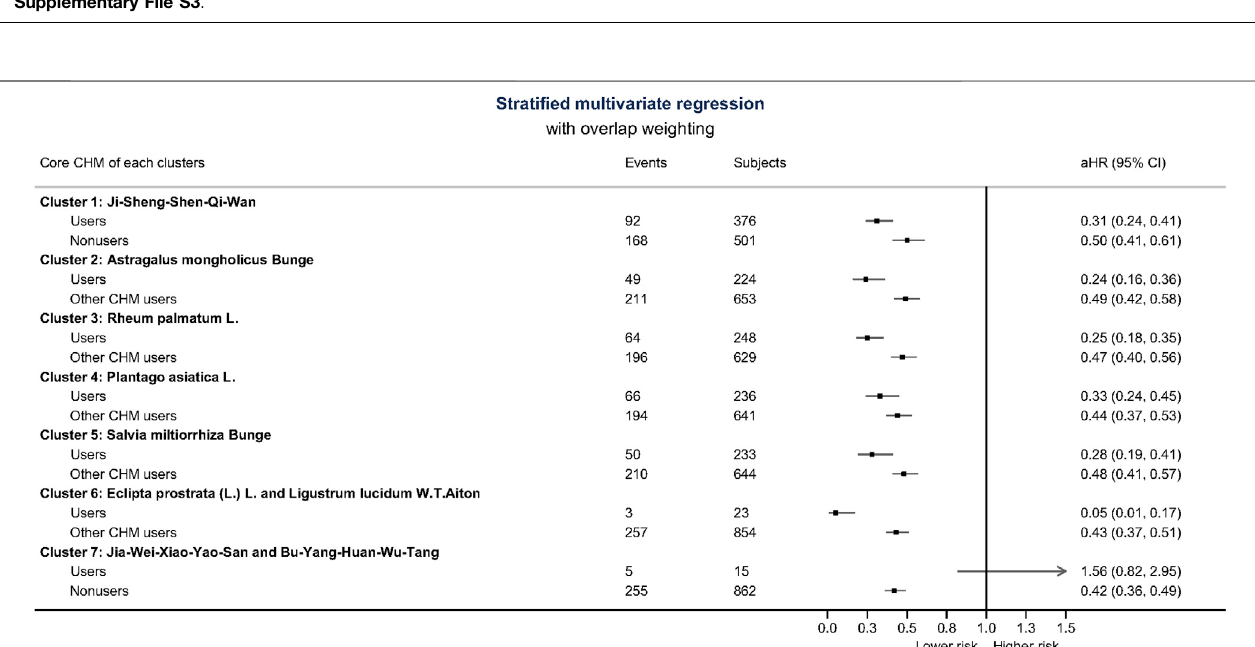
FIGURE6| Theassociations ofusingcoreChineseherbalmedicine(CHM)orotherCHMswithall-causemortalityreferencetoCHMnonusers.Generally,subjects using coreCHMwitheveryclusterhad lowerrisks.Cluster6and7arepresented astwoCHMsincombinationrather thancoreCHMsince therewereonlytwoCHMs in clusters 6 and 7. The composition of herbal formula (HF) is listed in Supplementary File S3 .